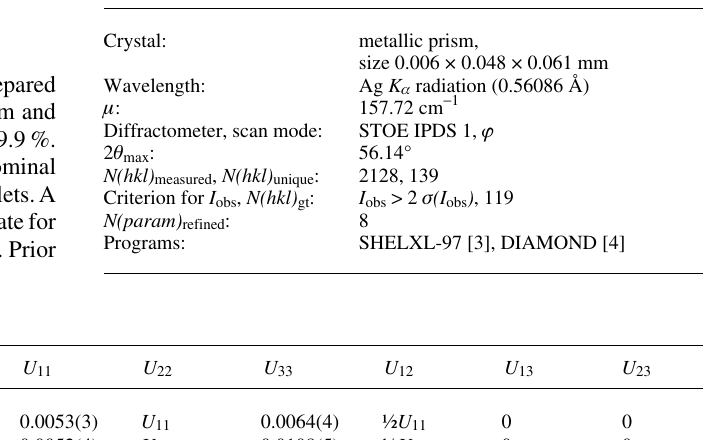
Table 1. Data collection and handling.